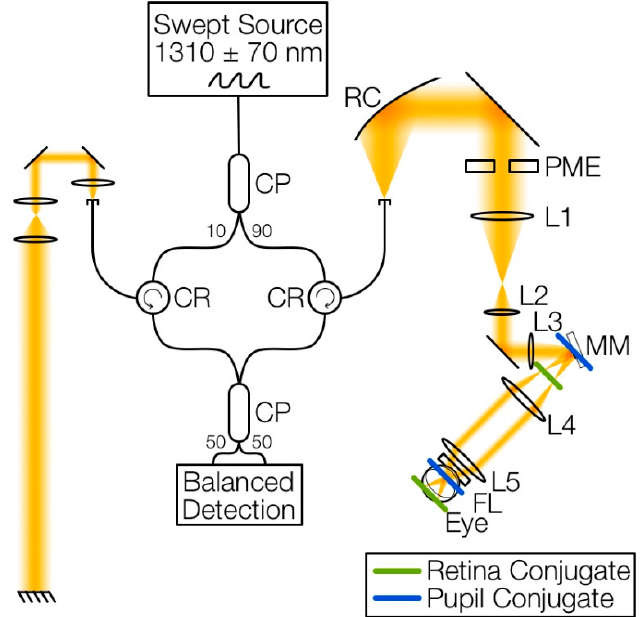
Figure 1. Diagram of the SAR-OCT system for murine retinal imaging. The design includes a 1310 nm ± 70 nm swept source laser and a fiber-based interferometer setup. (CP, fiber coupler; CR, fiber circulator). The sample arm includes a reflective collimator (RC), pathlength multiplexing element (PME), several gradient index lenses (L1–L5), a dual-axis MEMS mirror (MM) conjugate to the ocular pupil plane, and a fundus lens (FL) that interfaces with the mouse cornea. The reference arm includes three lenses for dispersion matching and a mirror pathlength-matched to the mouse’s retina. Permission was granted by the publisher to reprint this figure from Gardner et al. with minor modifications [19].